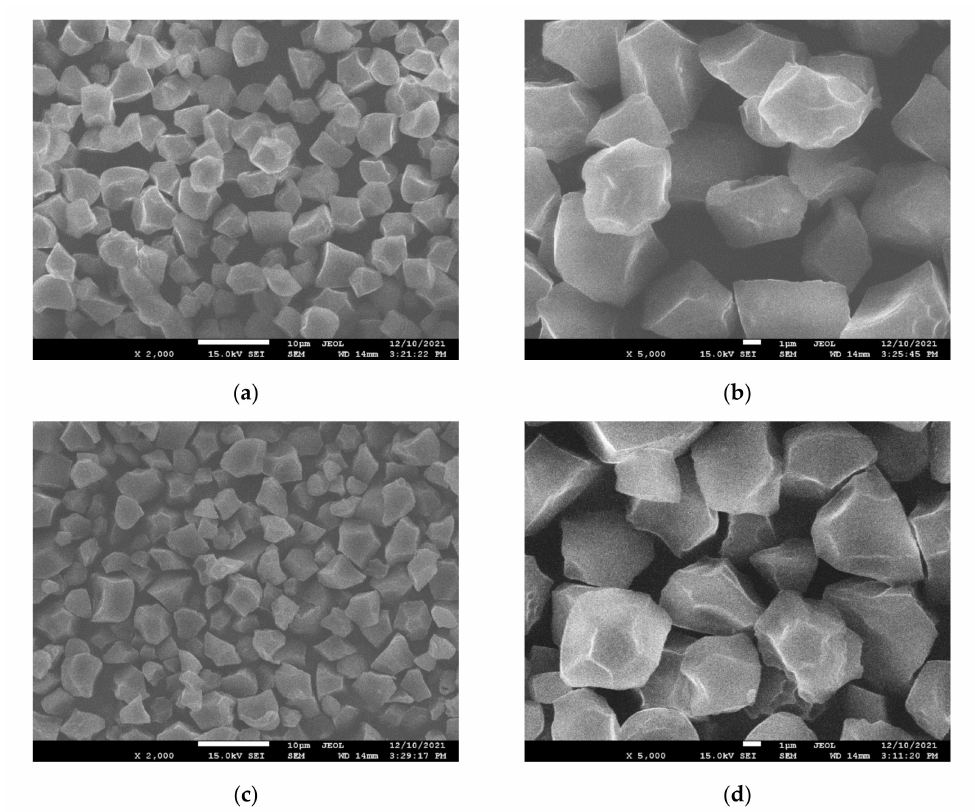
Figure 4. SEM of starch extracted from paddy rice under 50 Hz CTD and 50 Hz VTD: ( a , b ) 50 Hz CTD; ( c , d ) 50 Hz VTD.